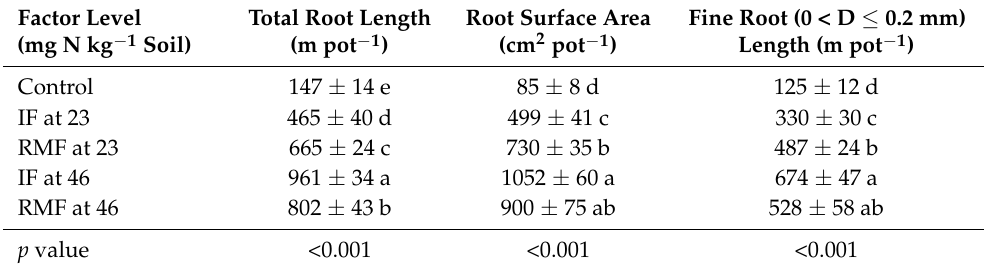
Table 5. Total root length, root surface area and fine root length as influenced by the interaction effect of fertiliser type (Ft) and fertiliser rate (Fr). Three-way ANOVA (Table 3) showed significant interaction effect of Ft × Fr (mean ± SE, n = 8). Means within a column followed by different letters differ significantly. Control, no fertiliser; IF, inorganic fertiliser; RMF, rock mineral fertiliser; D, average root diameter.